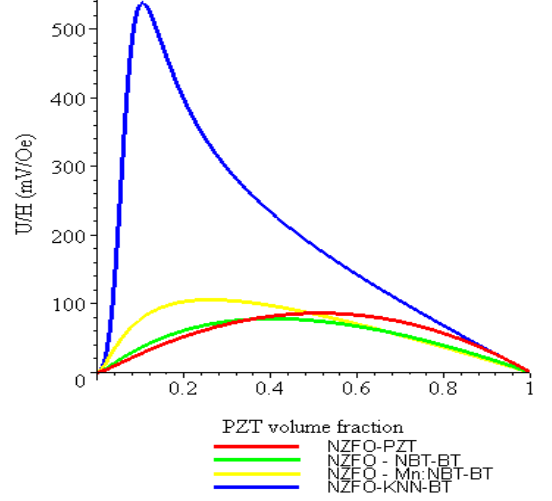
Figure 26. Piezoelectric volume fraction dependence of ME voltage coefficient for